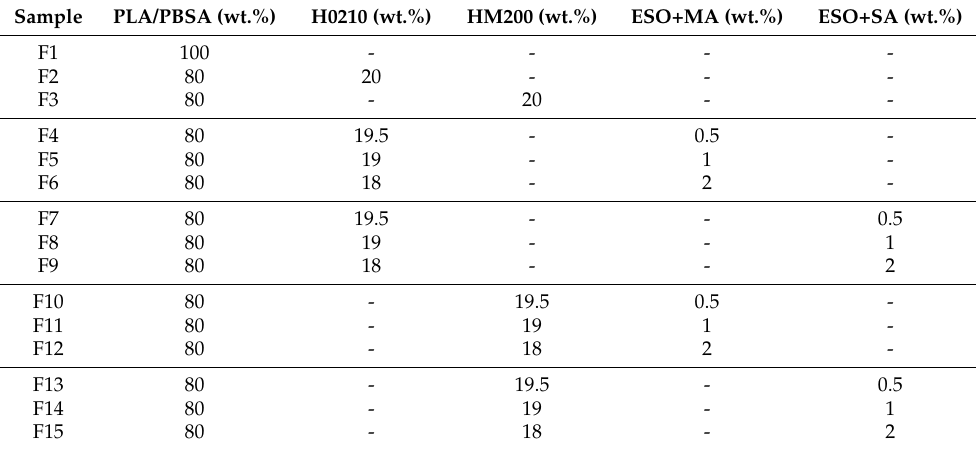
Table 1. Weight composition of prepared